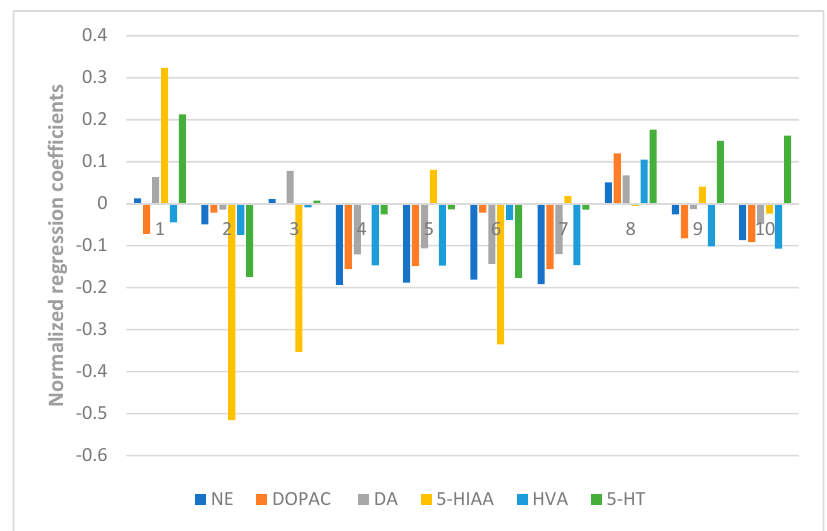
Figure 8. Normalized regression coefficients between the contents of the 10 ZZX samples and the content of monoamine neurotransmitters and their metabolites in the hippocampus of rats. 1 : Neochlorogenic acid, 2 : Chlorogenic acid, 3 : Cryptochlorogenin acid, 4 : Isochlorogenic acid B, 5 : Isochlorogenic acid A, 6 : Hesperidin, 7 : Isochlorogenic acid C, 8 : Unknown compound X, 9 : Unknown compound Y, 10 : Unknown compound Z. The regression coefficients were combined with the indices of the anti-anxiety effect, of which the regression coefficients of NE, DOPAC, DA, 5-HIAA, HVA, 5-HT were either positive, indicating a negative effect on anti-anxiety effect; or negative, indicating a positive effect on the anti-anxiety effect.